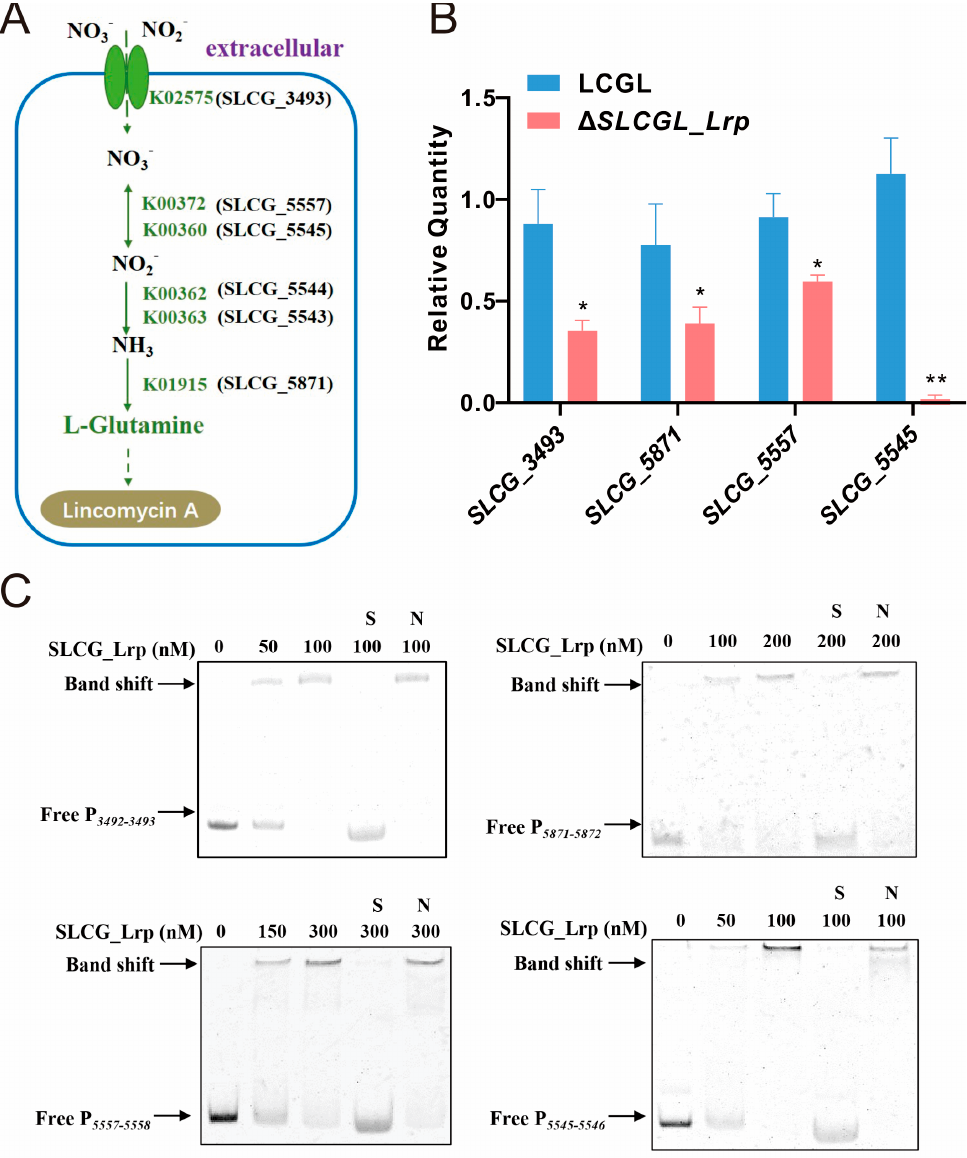
Figure 3. SLCG_Lrp directly promotes the transcription of nitrogen metabolism genes. ( A ) Biochemical metabolism map of DEGs enriched by the nitrogen metabolic pathway. ( B ) RT − qPCR analysis of nitrogen metabolization genes in LCGL and Δ SLCGL_Lrp . ( C ) EMSA analysis of SLCG_Lrp with the promoter regions of SLCG_3493, SLCG_5871, SLCG_5557, and SLCG_5543 − 5544 − 5545. S: unlabeled speci fi c probe (20 − fold); N: nonspeci fi c probe poly dIdC (20 − fold). The mean values of three replicates are shown, with the standard deviations indicated by error bars. * p < 0.05, ** p < 0.01. To determine whether SLCG_Lrp directly promotes the transcription of SLCG_3493 , SLCG_5543 - 5544 - 5545 , SLCG_5557 , and SLCG_5871 , we examined their a ffi nity with the aforementioned gene promoters by EMSA analyses. Based on our results, SLCG_Lrp could bind to the promoter regions of SLCG_3493 , SLCG_5543 - 5544 - 5545 , SLCG_5557 , and SLCG_5871 (Figure 3C). In addition, 20-fold unlabeled probes can dramatically compete with labeled probes for binding to SLCG_Lrp (Figure 3C). When a nonspeci fi c DNA, poly